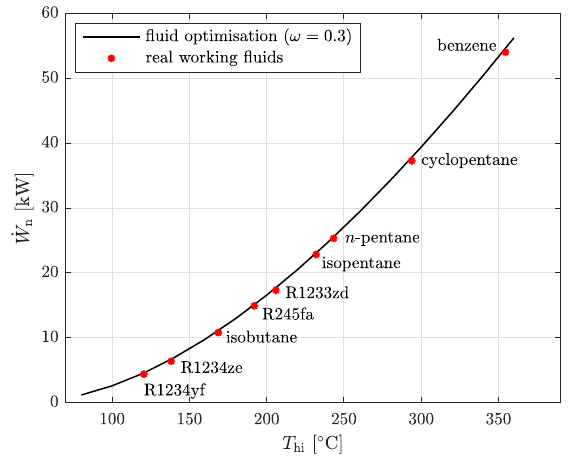
Figure 10. Comparison between the results from an integrated working-fluid and cycle optimisation with ω = 0.3 (line) and cycle optimisations completed for predefined working fluids (markers) for subcritical cycles. For all optimisation studies, the condensation pressure is